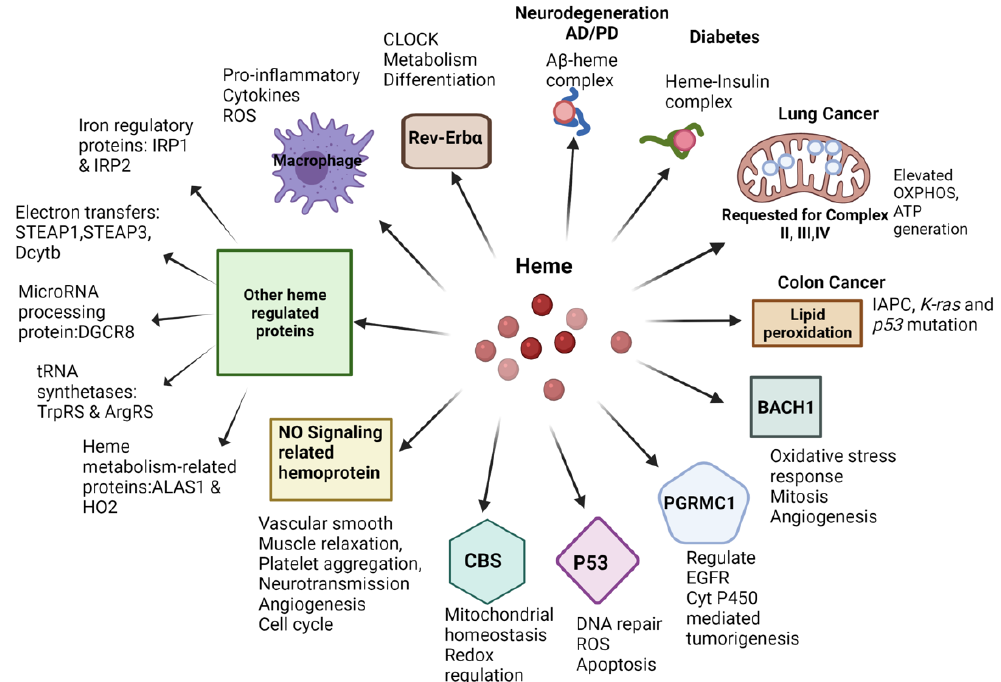
Figure 3. Illustration summary of heme regulation in diverse molecular and cellular processes. (Created with BioRen- der.com).